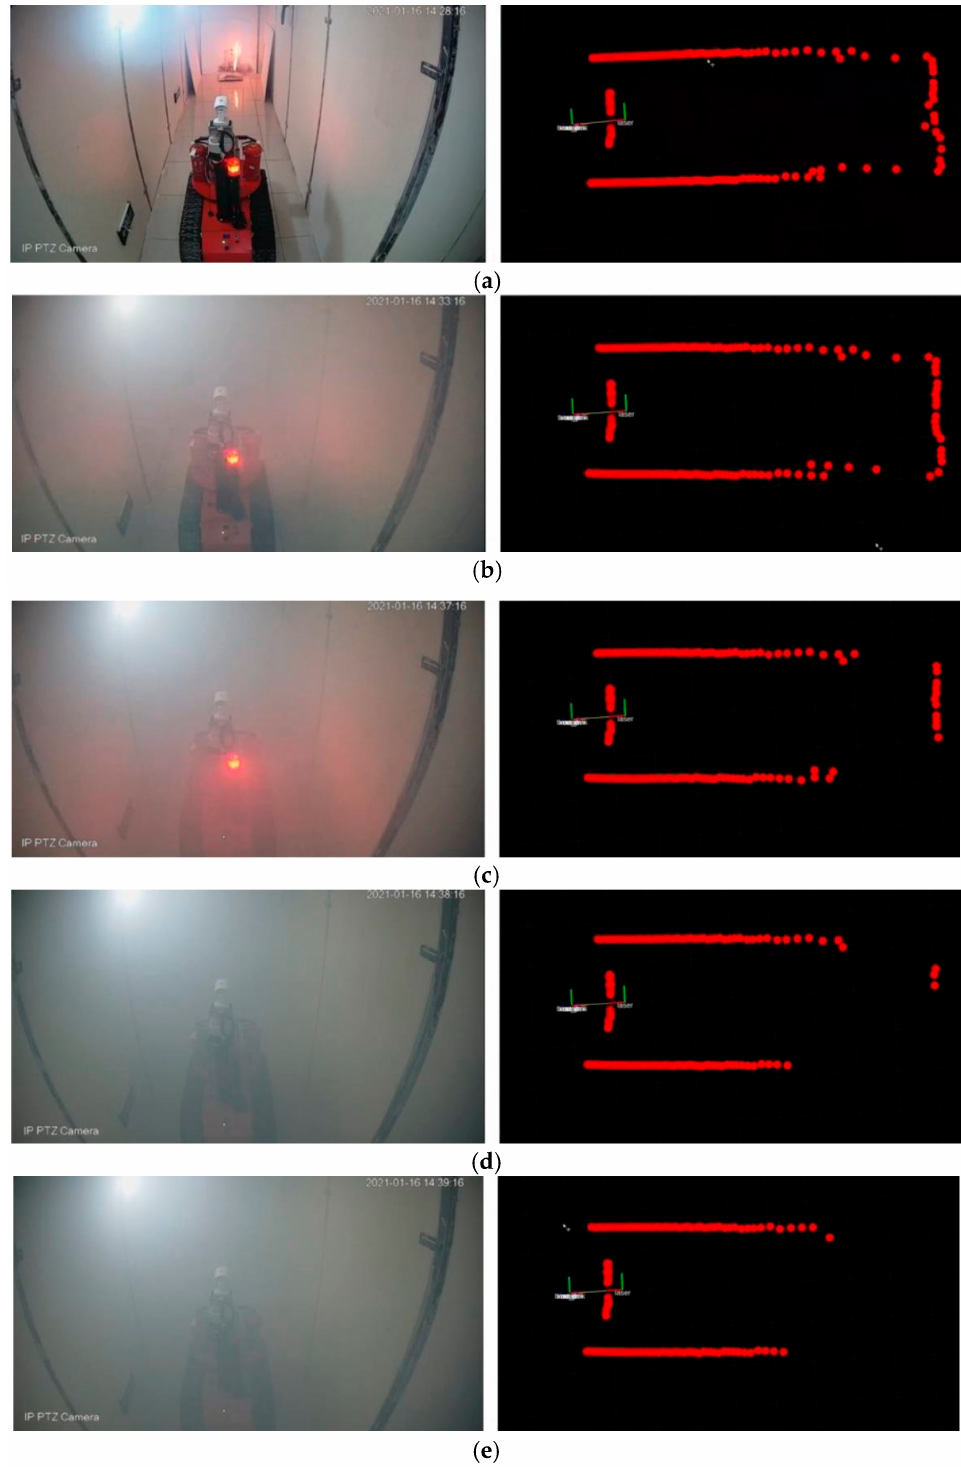
Figure 17. Laser point cloud in the fire environment: ( a ) Freshly lit cotton rope. ( b ) Cotton rope lit for 5 min. ( c ) Cotton rope lit for 9 min. ( d ) Cotton rope lit for 10 min. ( e ) Cotton rope lit for 11